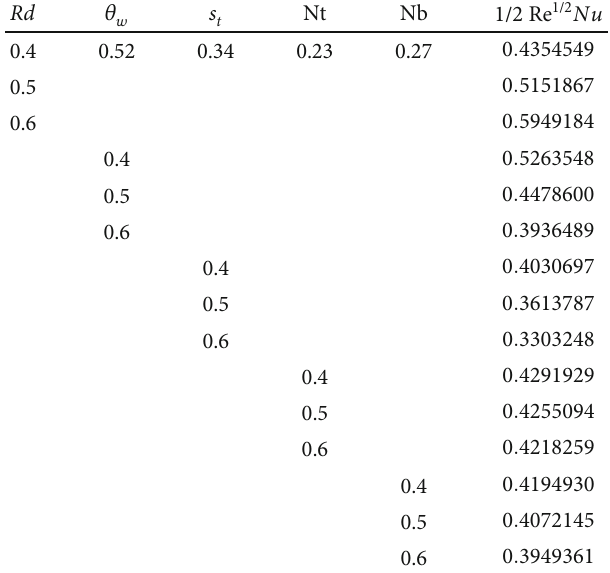
Table 3: Impact of various physical parameters over the Nusselt number ð 1/2 Þ Re 1/2 Nu when R = 0 : 3, γ ∗ = 0 : 3, and γ = 0 : 3when ϕ = 12 % and ϕ = 13 % 2